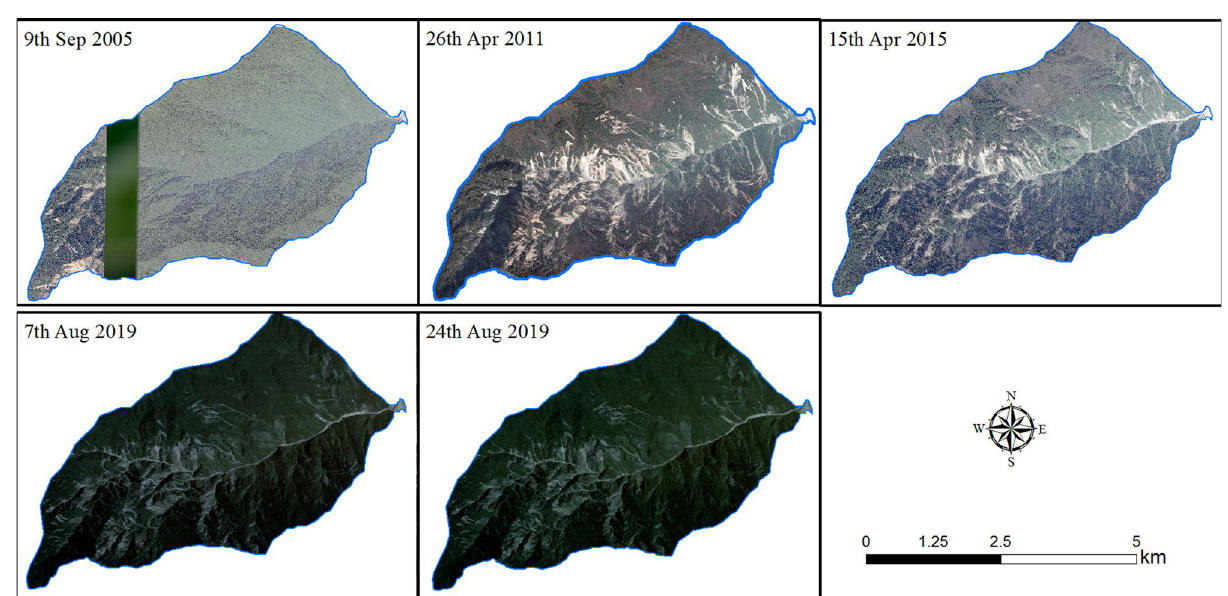
Figure 5. Digital stereoscopic images used in this paper.The data sources in the figure are shown in Table 2. Maps constructed using ArcGIS 10.2 (https:// deskt op. arcgis. com/